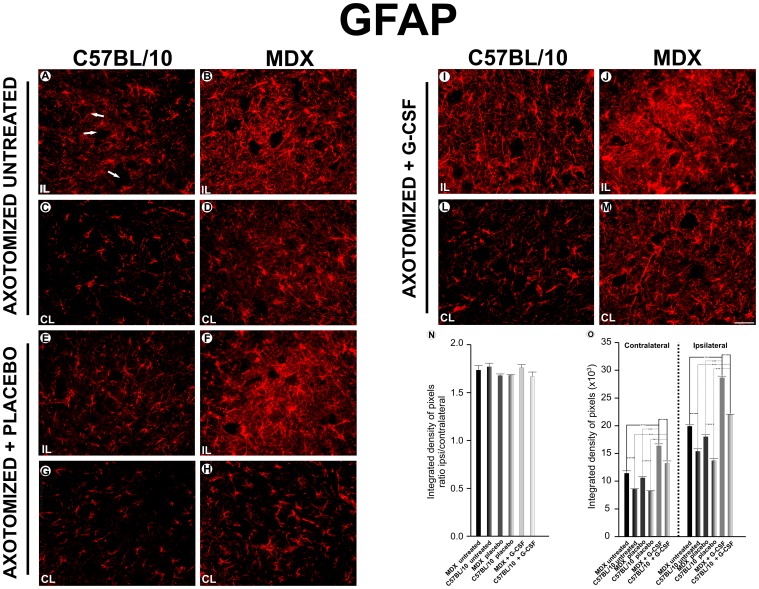
Anti-GFAP immunostaining one week after axotomy.
A and C, the ipsilateral (IL) and contralateral ventral column of the spinal cord of the C57BL/10 strain seven days after axotomy; B and D, the ipsilateral and contralateral ventral column of the spinal cord of the MDX seven days after axotomy; E and G, the ipsilateral and contralateral of the C57BL/10 ipsilateral+ placebo group seven days after the axotomy; F and H, the ipsilateral and contralateral of the MDX ipsilateral+ placebo group; I and L, the ipsilateral and contralateral of the C57BL/10 ipsilateral+ G-CSF group; J and M, the ipsilateral and contralateral of the MDX ipsilateral+ G-CSF group. In all experiments: n = 5. In A–M, magnification, X200 (scale bar, 50 µm).The alpha-motoneurons were quantified in 3 distinct fields along the lumbar intumescence. In N, ***p<0.001 vs. CT, values are means ± SEM.